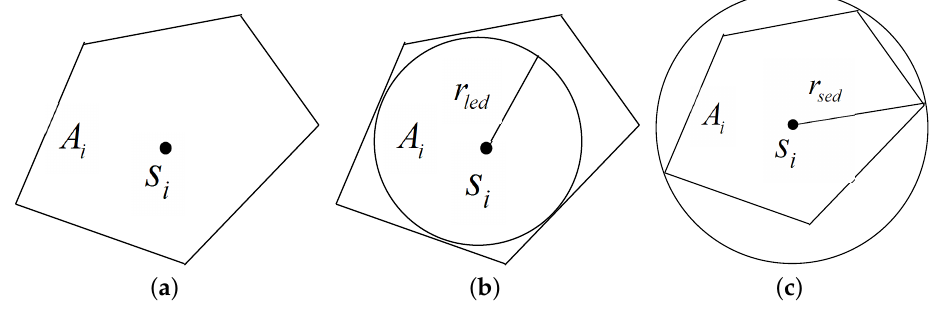
Figure 5. Convex sensing region. ( a ) Convex sensing range; ( b ) largest enclosed disk; ( c ) smallest enclosing